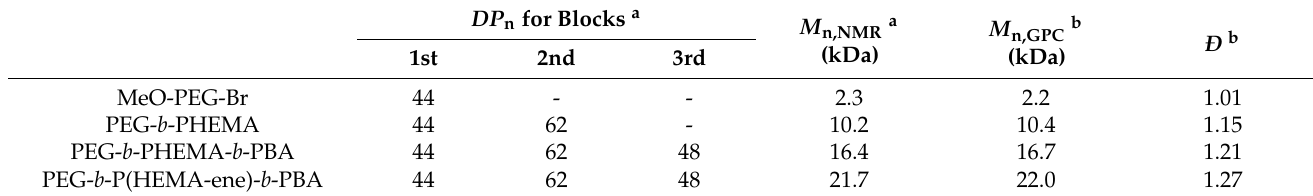
Table 1. Structural parameters of